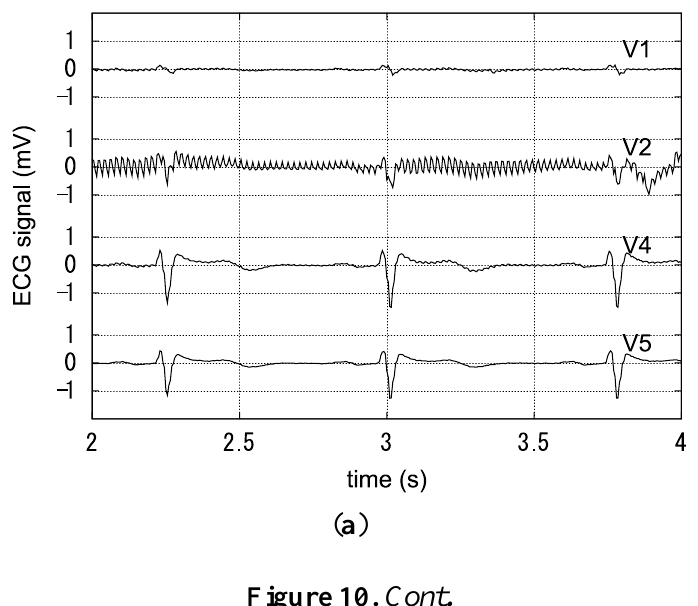
Figure 9. Subject wearing our smart shirt.